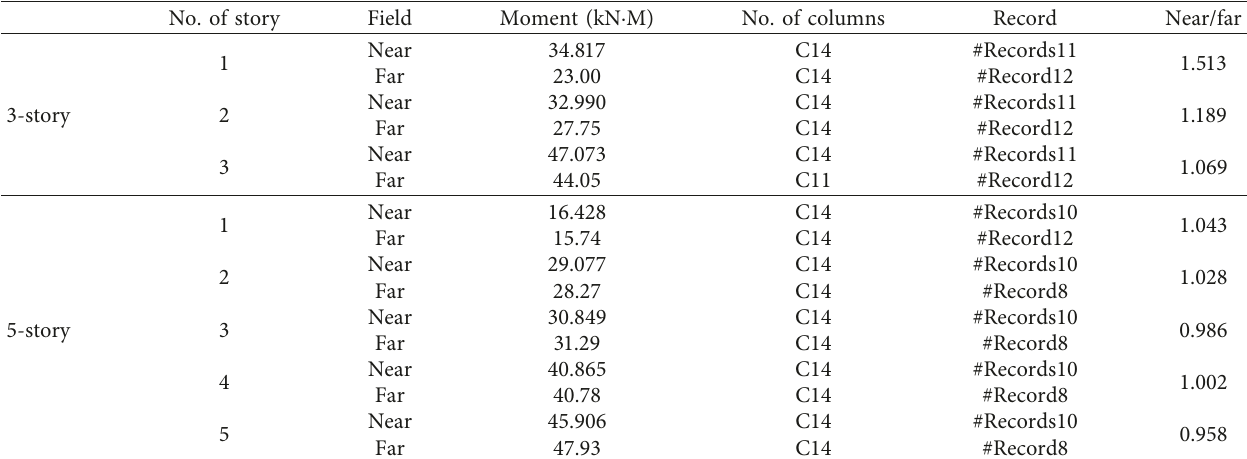
Table 6: Comparison of the maximum moment of columns in 3-, 5-, 8-, and 20-story buildings subjected to near- and far-field earthquakes. No. of